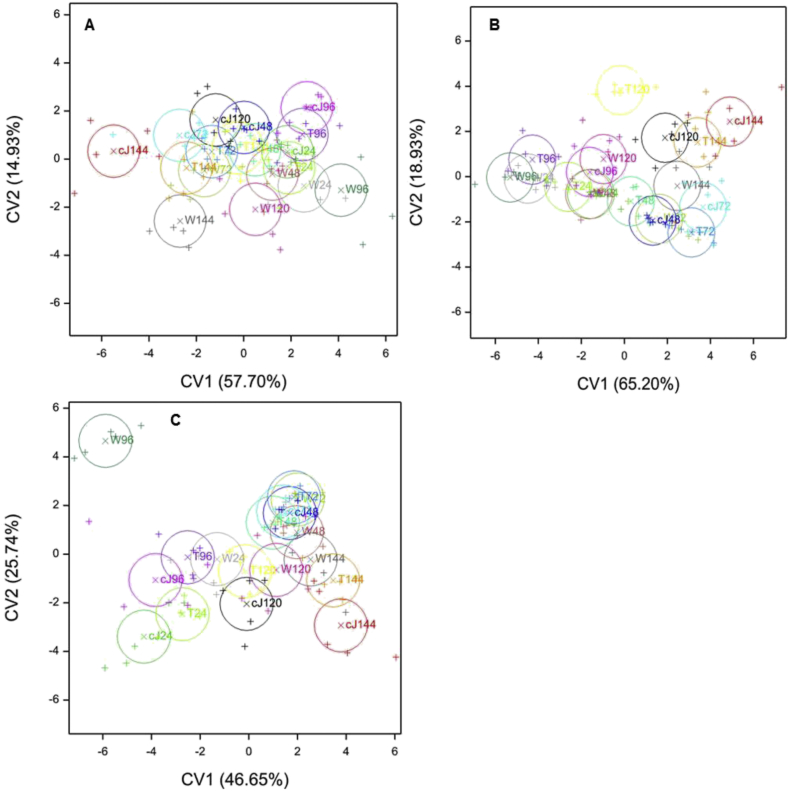
Canonical variates analysis (CVA), plots of scores (plusses) and means of scores (crosses) for combinations of treatments: H2O (W), Tween 20 (T), cis-jasmone (cJ), and time points: 24 h (24), 48 h (48), 72 h (72), 96 h (96) and 144 h (144), for each soybean cultivar BRS 134 (A), IAC 100 (B) and Dowling (C). The mean of scores (in the two dimensions, CV1 and CV2) for each combination is surrounded by a 95% confidence circle; non-overlapping circles indicate statistical difference (P < 0.05). The percentage variance (discrimination) accounted for in each of the dimensions is given in parenthesis with the axes labels.